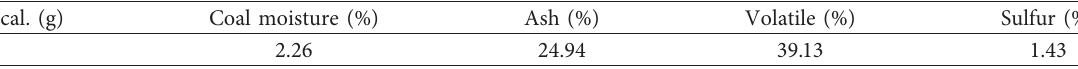
Table 1: Industrial analysis parameters of the coal samples.